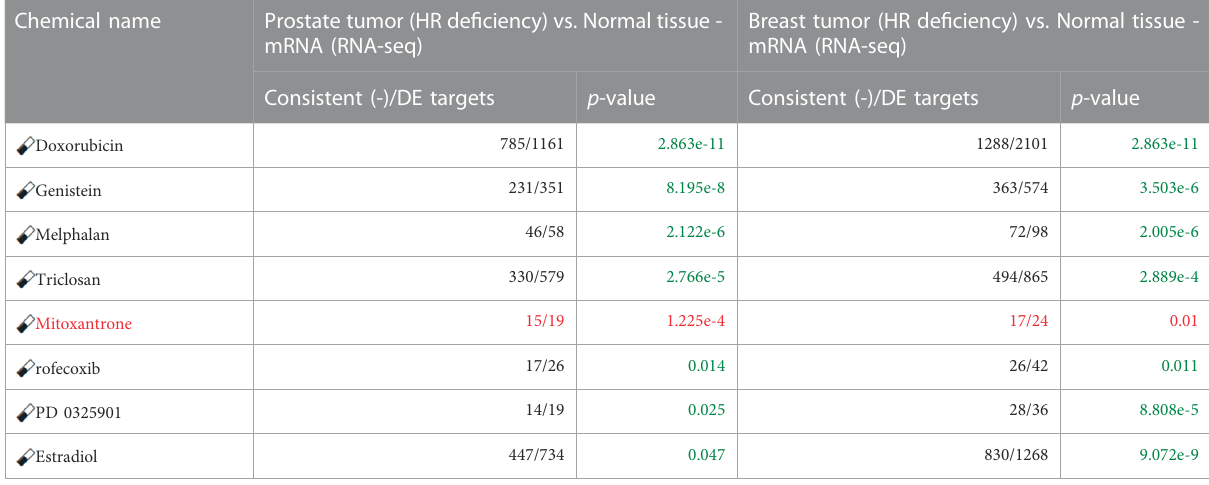
Figure 6. Figure 7 A shows the most signi fi cant genes based on their contribution towards prediction using breast, prostate, and ovarian tissues. The biomarkers discovered using this approach were further used to fi nd disrupted pathways using the impact analysis. The drugs identi fi ed using cross cancer genes are listed in Figure 7B and are discussed in detail in the Discussion